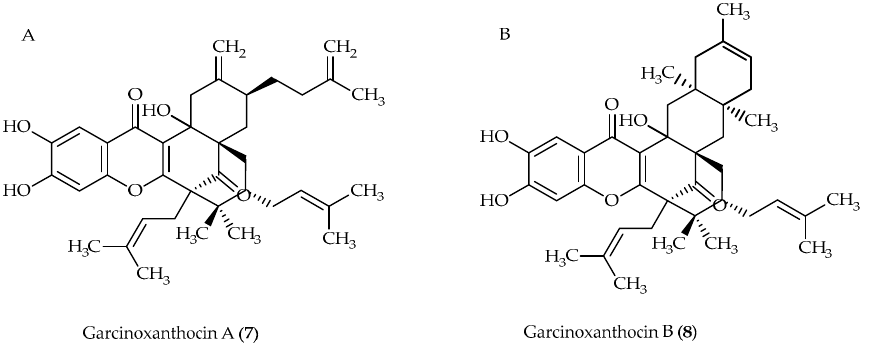
Figure 5. Chemical structures of Garcinoxanthocin derivatives.